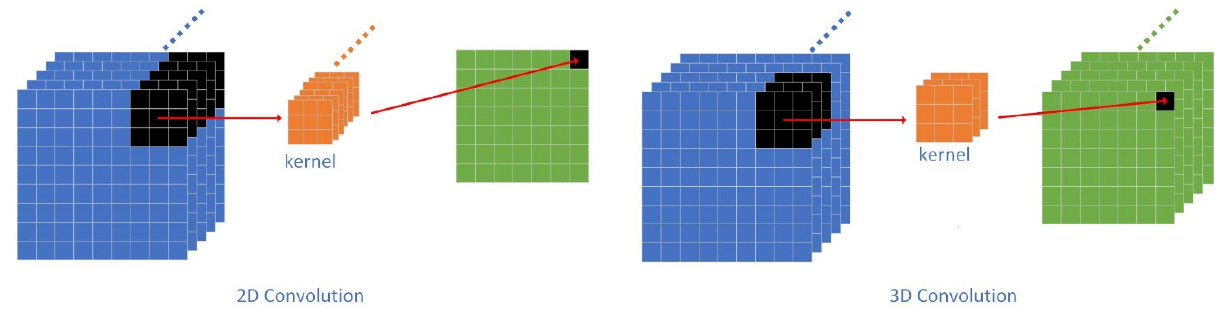
Figure 2. Two-dimensional convolution process and three-dimensional convolution process.